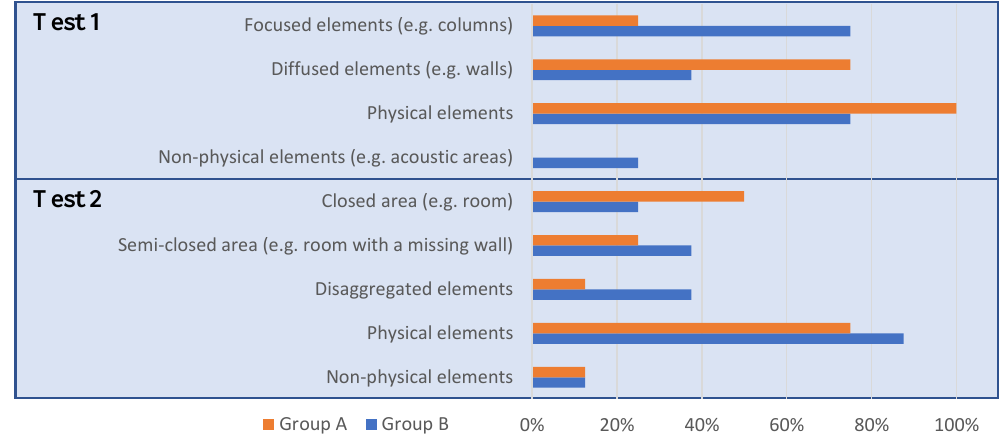
Figure 9. Common features of the scenarios described and drawn by the subjects.